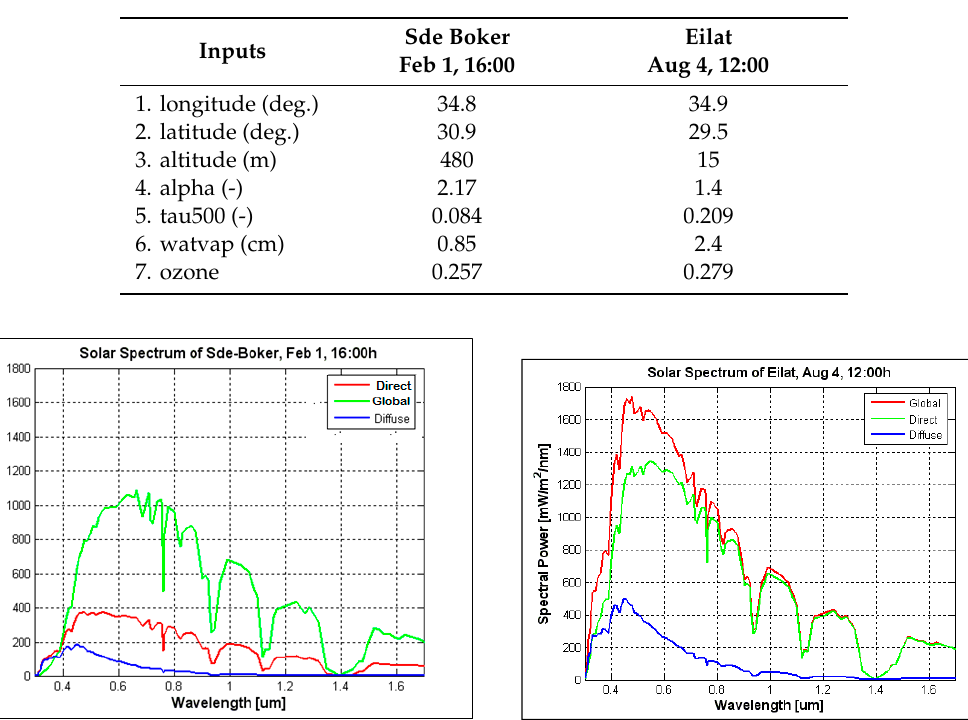
Table 2. Data for obtaining the solar spectrum .